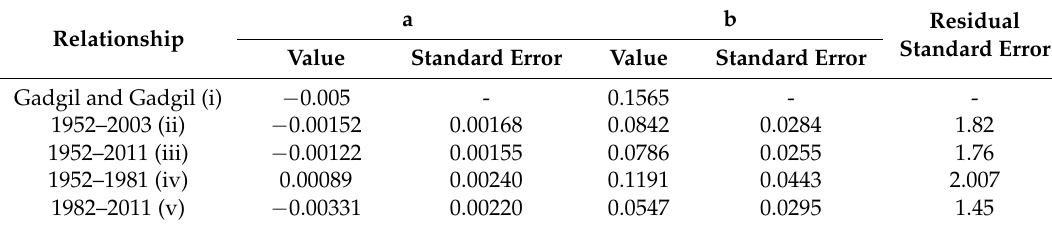
Table 2. Coefficients for the modelled (quadratic) relationships between ISMR and GDP as described in Figure 4, where a is the coefficient for the quadratic term and b is the coefficient for the linear term. Additionally, the standard error of the deviation of the relevant data points shown and the modelled curve. The standard error calculated for (i) is based on the updated datasets used for the other relationships but using the years and constants as given in Reference